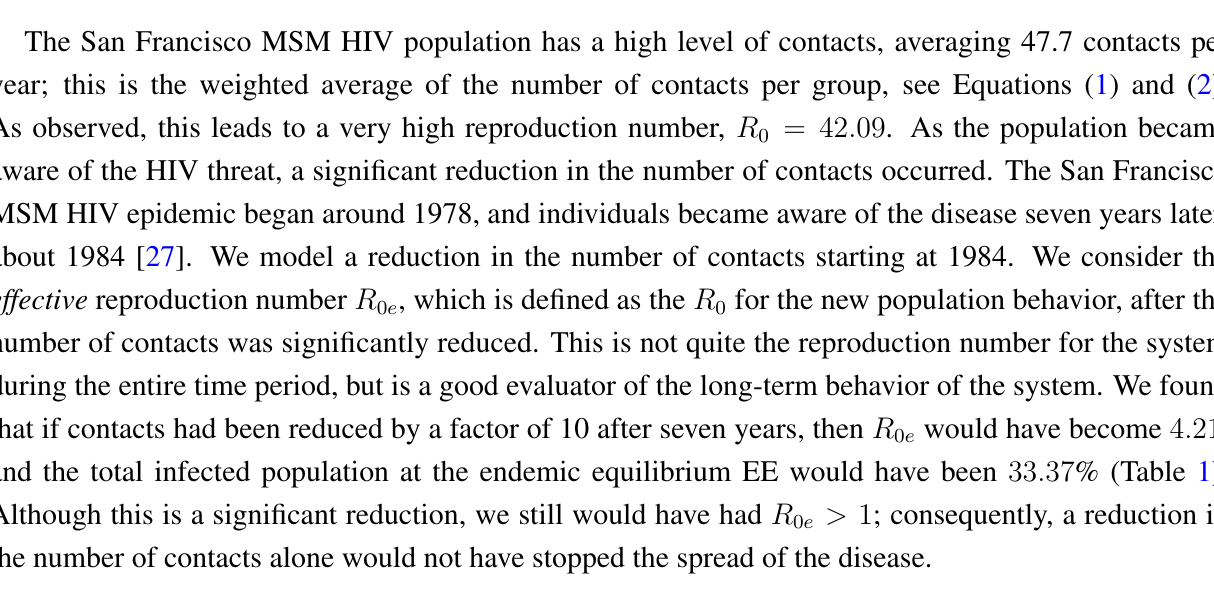
Table 1. Reproduction number and total infected population at the endemic equilibrium for reduction